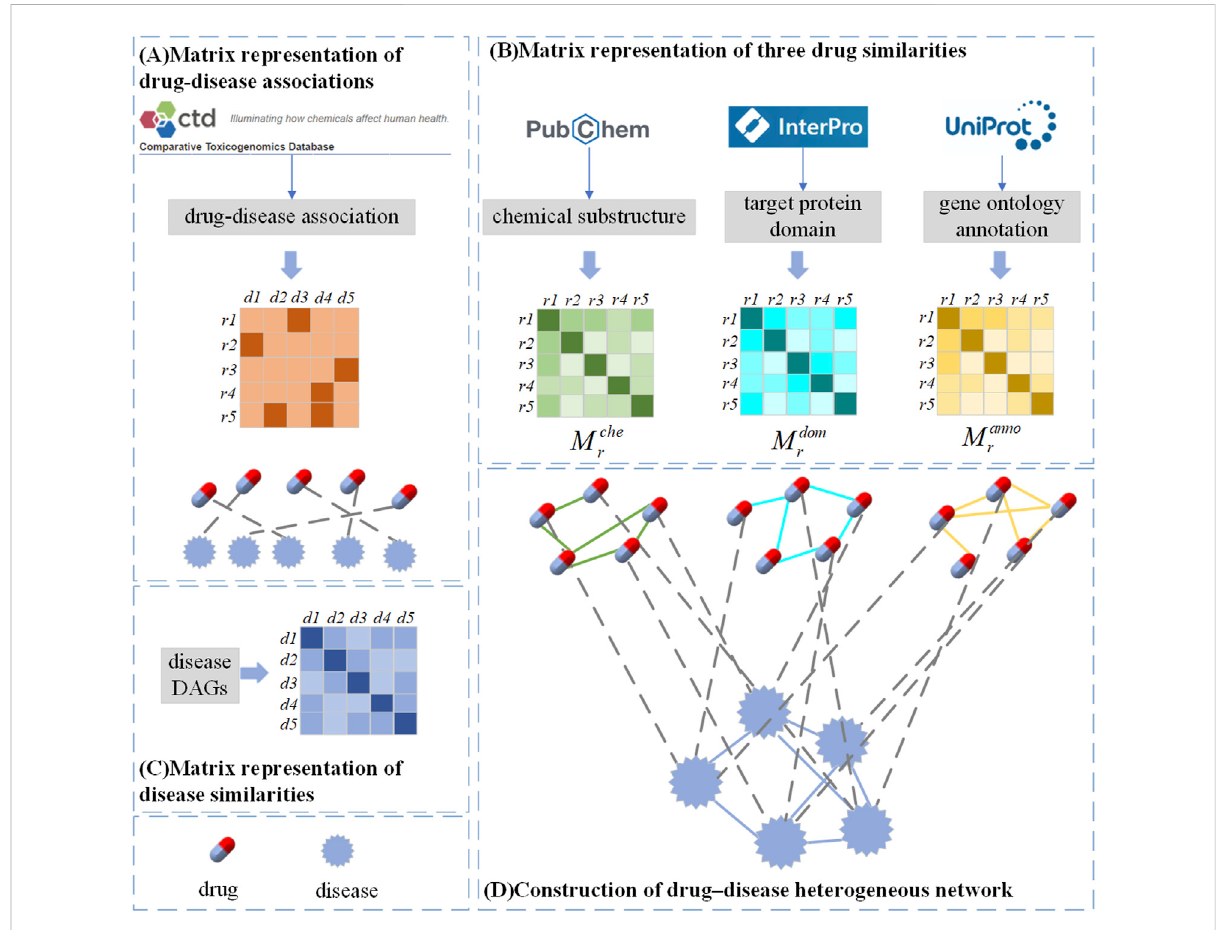
FIGURE 1 (A) matrix representation of drug-disease associations, (B) matrix representation of three drug similarities, (C) matrix representation of disease similarities, (D) construction of drug – disease heterogeneous